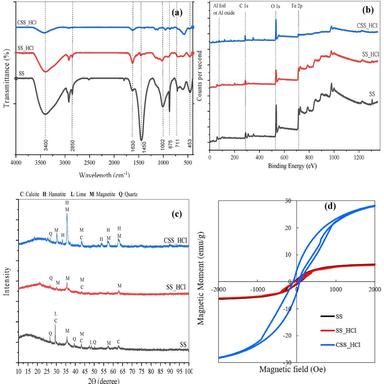
Characterisation of synthesised catalysts: a) FTIR Spectra, b) XPS spectra, c) XRD spectra, and d) Magnetisation curve showing hysteresis loop under narrow magnetic field (-2 kOe to þ2 kOe).